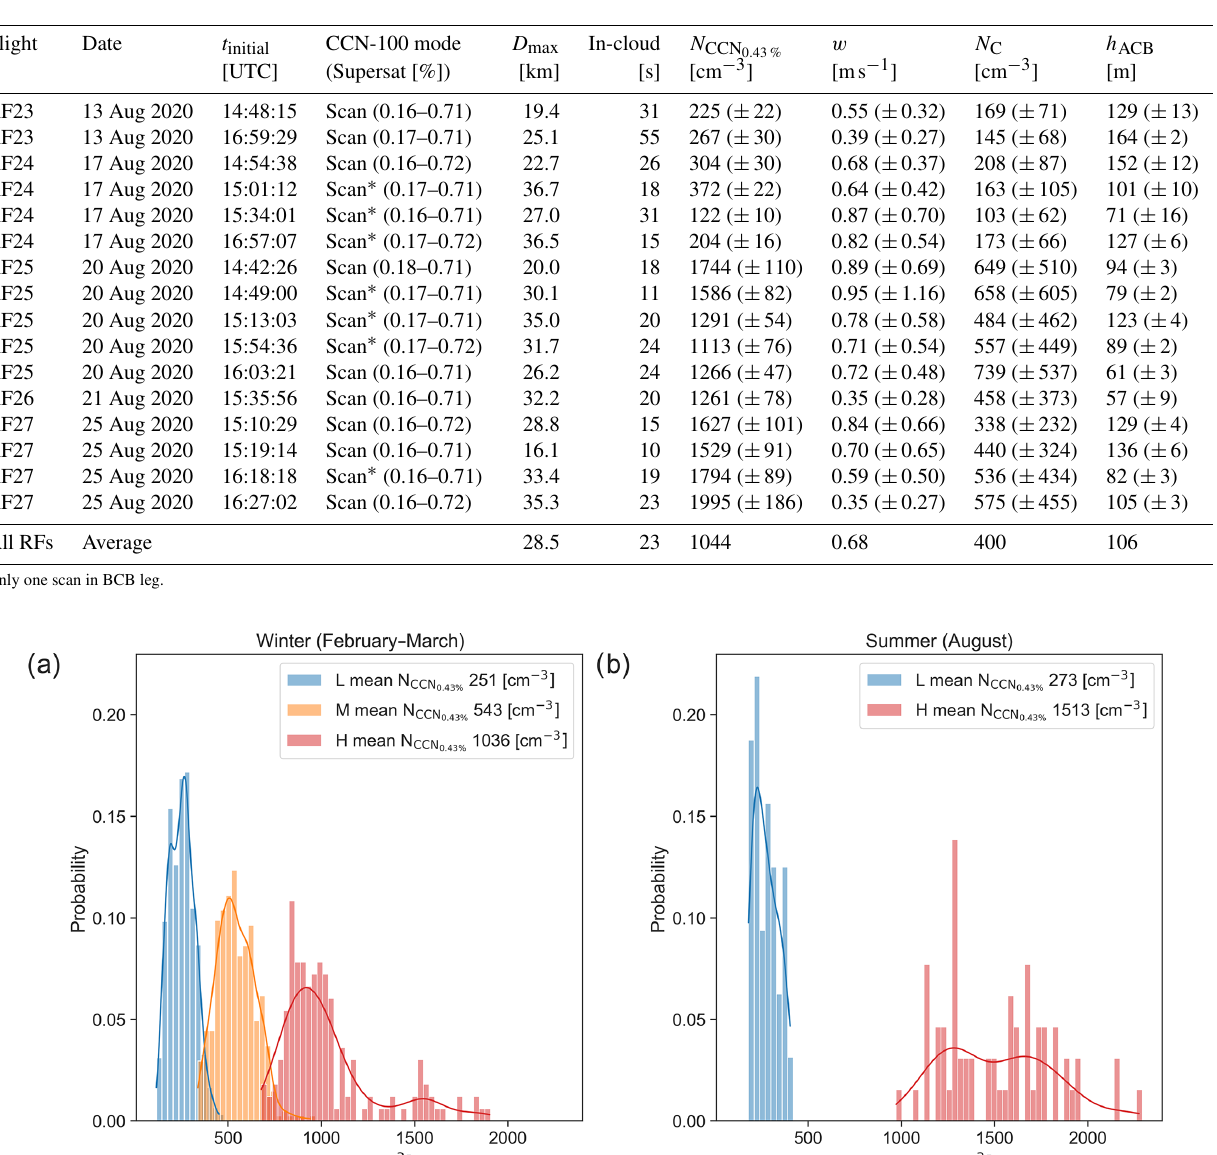
from the BCB legs. D max is the 0 . 43%